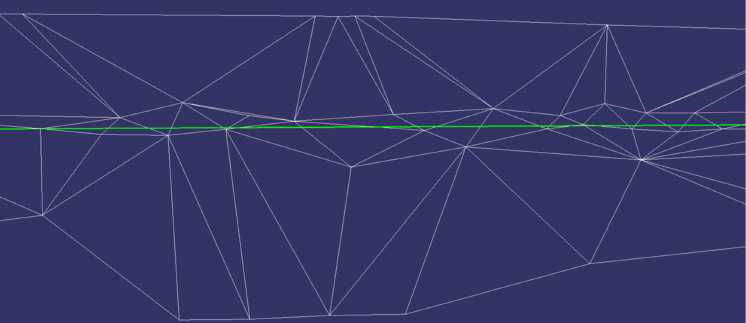
Figure 6. Diagram of the effect of local triangle projection on the projection plane. Green line is the feature line of the edge line, and the white lines are TINs of the building model.